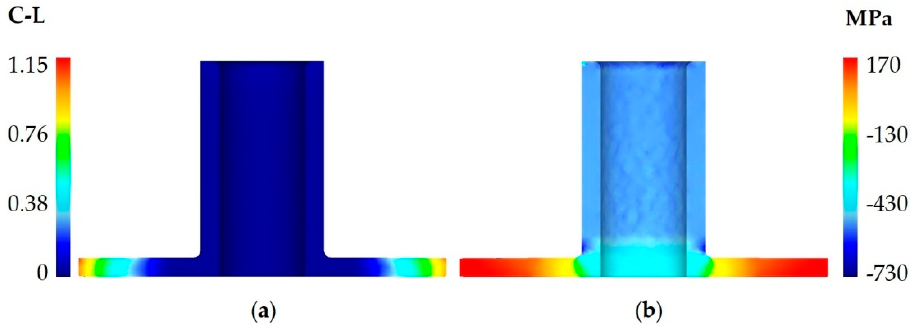
Figure 8. Distribution of ( a ) the normalized Cockcroft–Latham ductile fracture criterion and ( b ) circumferential stresses in a 59.5 mm diameter flange.